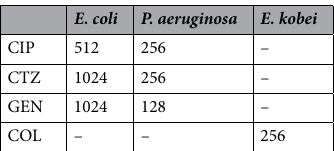
Table 1. Stock solution concentrations of the tested antibiotics in